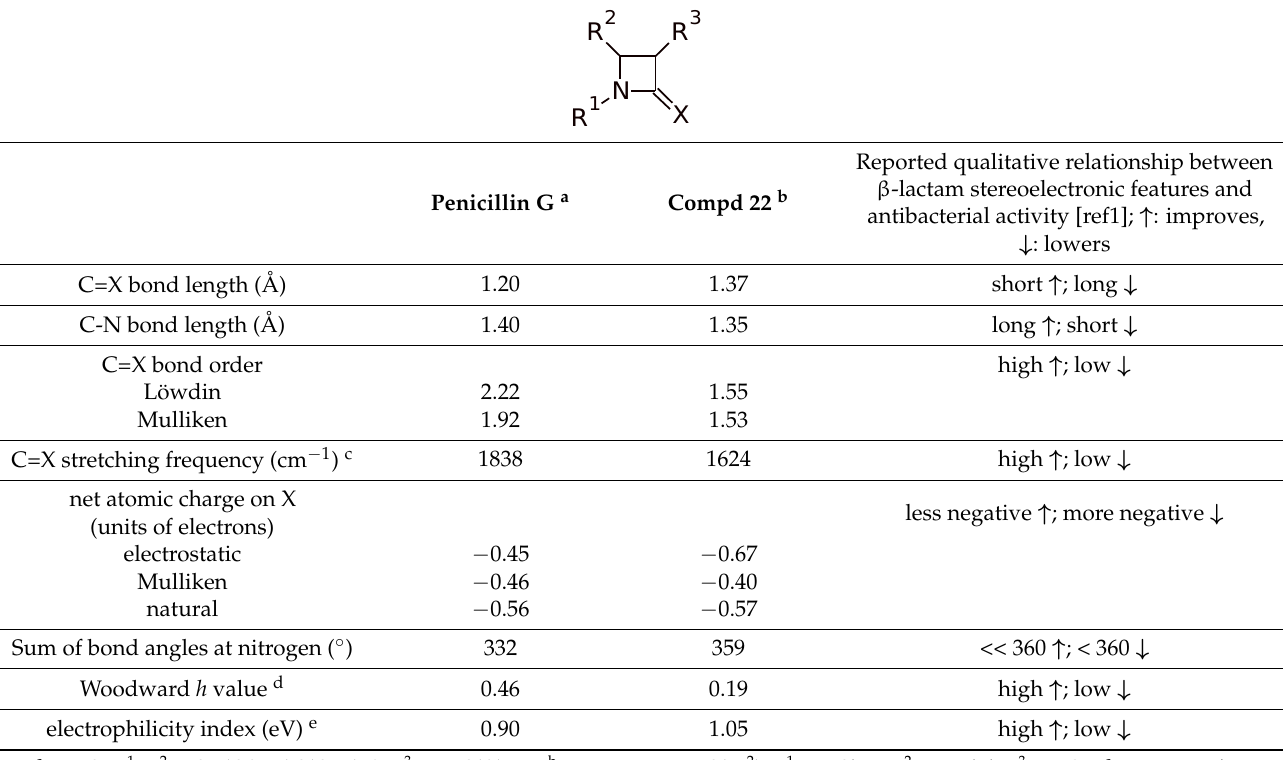
Table 2. Comparison of the Main Stereoelectronic Features of the Azetidine Rings in Penicillin G and 2-Nitroazetidine 22